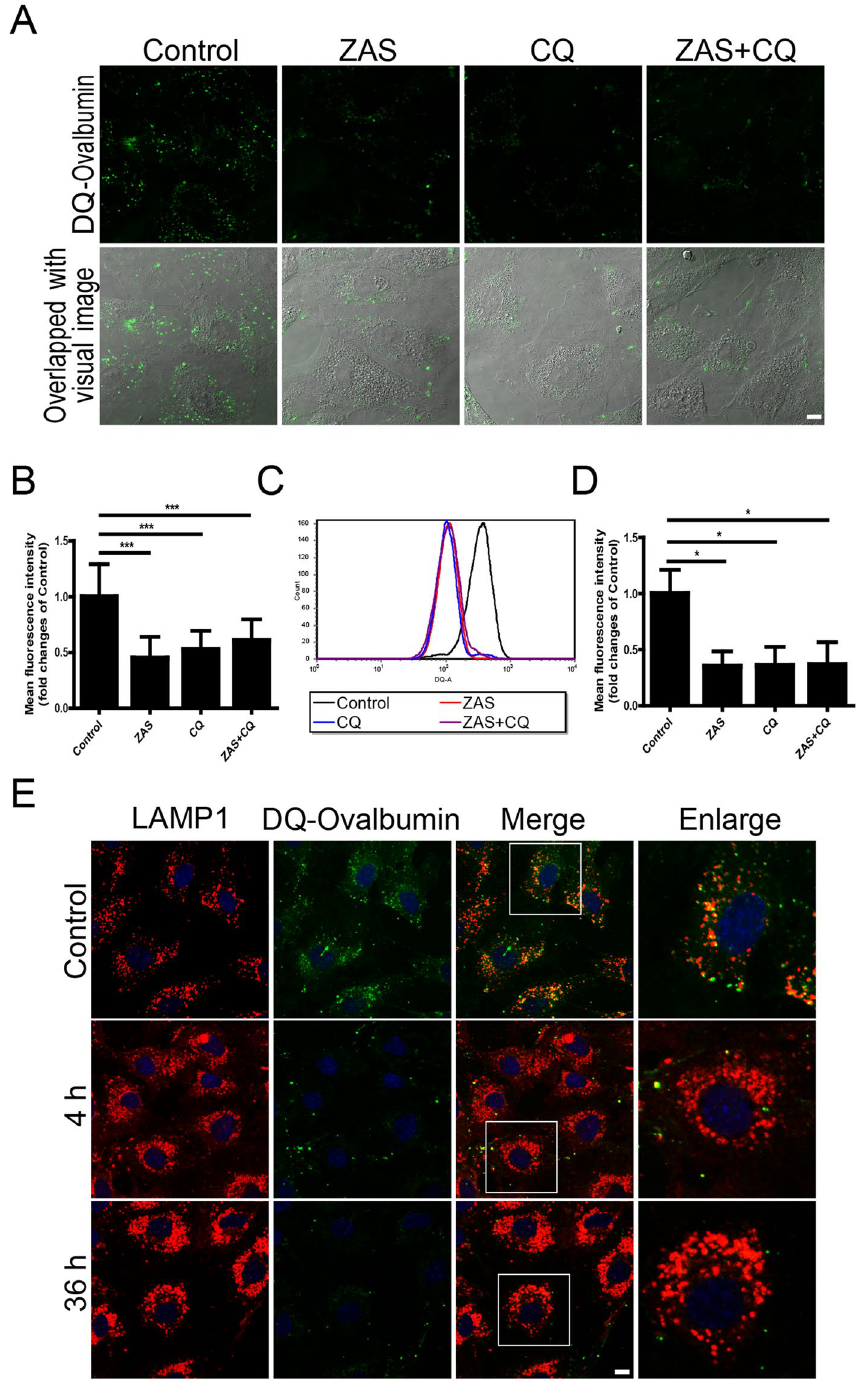
Figure 9. Zymosan activation serum (ZAS) induces declined degradability of lysosomes in podocytes. ( A , B ) Significantly declined proteolytic degradation of lysosomes was demonstrated by staining with DQ-ovalbumin, a self-quenched substrate for proteases, in podocytes after exposure to ZAS, chloroquine (CQ, 10 μ M), or ZAS plus CQ (10 μ M) for 4 h. ( C , D ) Representative histogram obtained from DQ-ovalbumin staining followed by flow cytometric analysis indicated the decreased DQ-ovalbumin signals and mean fluorescent intensity in podocytes after exposure to ZAS with or without CQ (10 μ M) for 4 h. ( E ) Immunofluorescent analysis of LAMP1-labeled lysosomes (red) and the dequenched DQ-ovalbumin vesicles (green) showed the lysosomal degradation of DQ-ovalbumin was compromised in podocytes after exposure to ZAS from 4 h to 36 h. Images were obtained using a confocal microscope and the mean fluorescent intensity of DQ-ovalbumin in podocytes was quantified using Leica confocal software. Scale bar, 10 μ m. * P < 0.05, *** P <